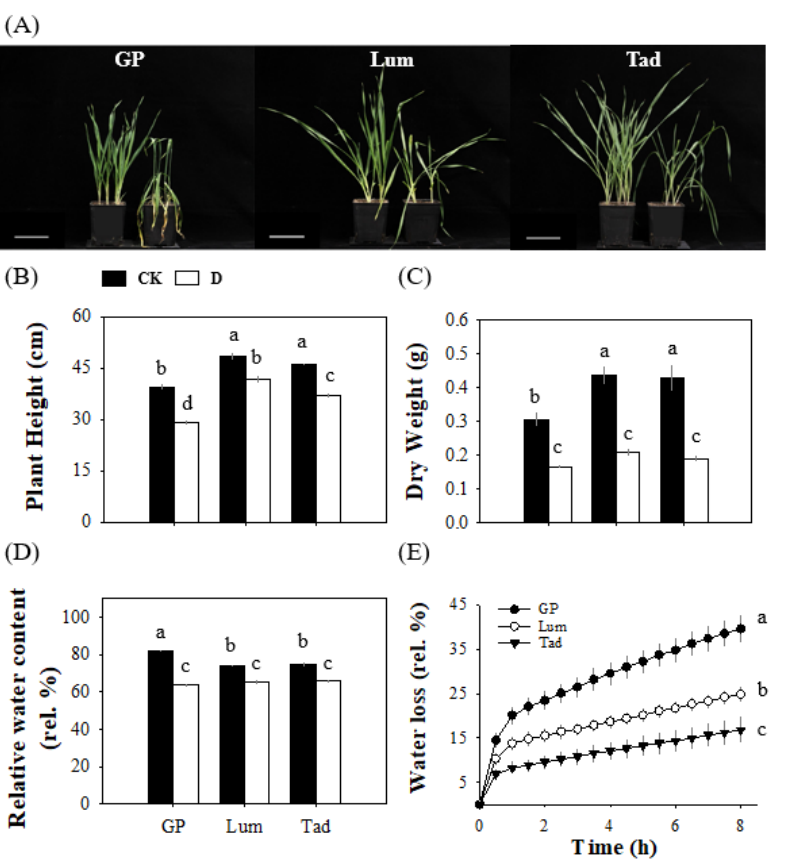
Figure 1. Different responses in three barley accessions under drought stress. ( A ) Drought performance of GP, Lum, and Tad after watering was ceased for 21 days. Scale bar: 5 cm. ( B ) Plant height, ( C ) dry weight (above ground), and ( D ) relative water content (RWC) in the leaves of GP, Lum, and Tad under control (CK, black bar) and drought (D, white bar) treatments. ( E ) Water loss in the detached leaves of GP, Lum, and Tad. Data are presented as means ± se ( n = 3–5). Different letters above the error bars indicate significant differences at p < 0.05.